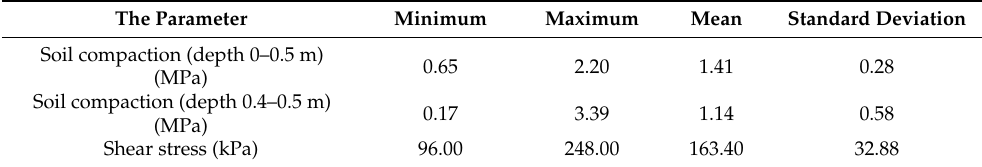
Table 1. Statistics of the experimental data.